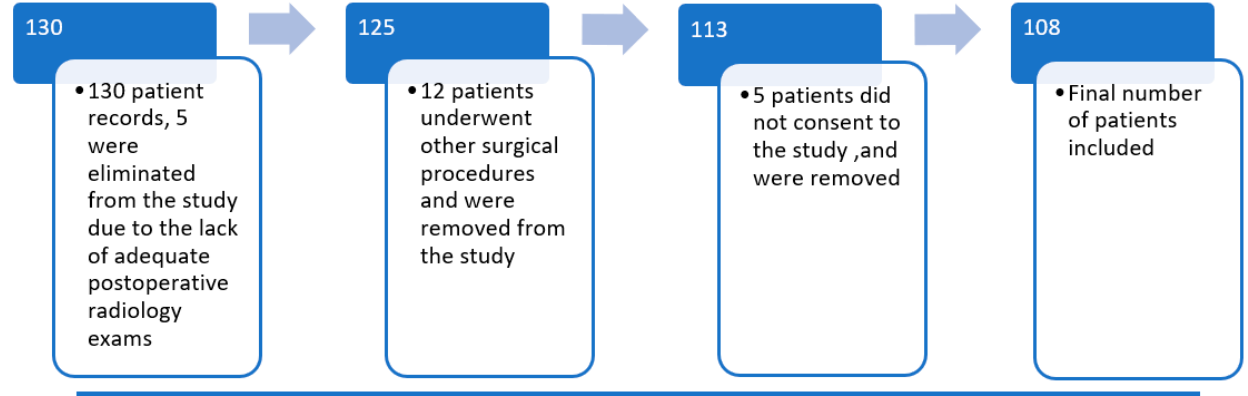
Figure 2. Flow diagram of the patients included in the study. After inclusion and exclusion criteria were applied, 108 patients remained in the study.